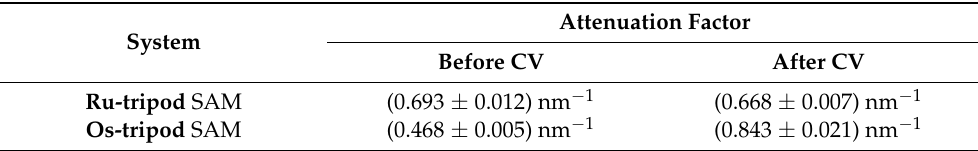
Figure 9. 2D semilogarithmic histogram of tunneling current–distance (I–z) curves for the Ru-tripod SAM on Au(111): ( a ) before; ( b ) after cyclic voltammetry experiment. Three sets of I–z curves were measured starting at setpoint currents of 0.1 nA, 0.2 nA and 0.4 nA. Approach rate was 1 nm s − 1 , bin size log(I) = 0.02, z = 0.02 nm. Red line represents the best least square fit of the most probable log(I) values as a function of z. Table 2. Attenuation factor β for Au|SAM systems obtained from tunneling current–distance curves by statistical